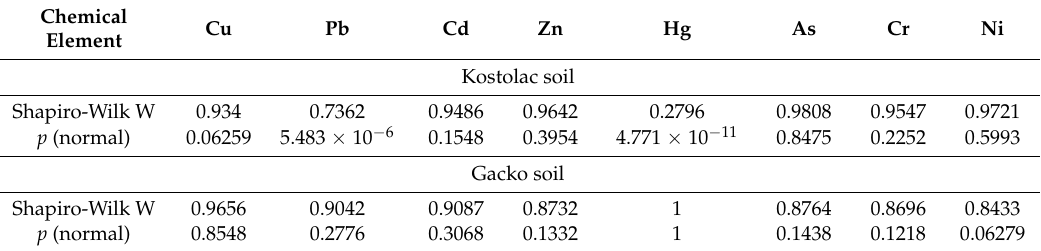
Table 4. The Shapiro-Wilk normality test applied on the results of heavy metal content in the surroundings of Kostolac and Gacko coal